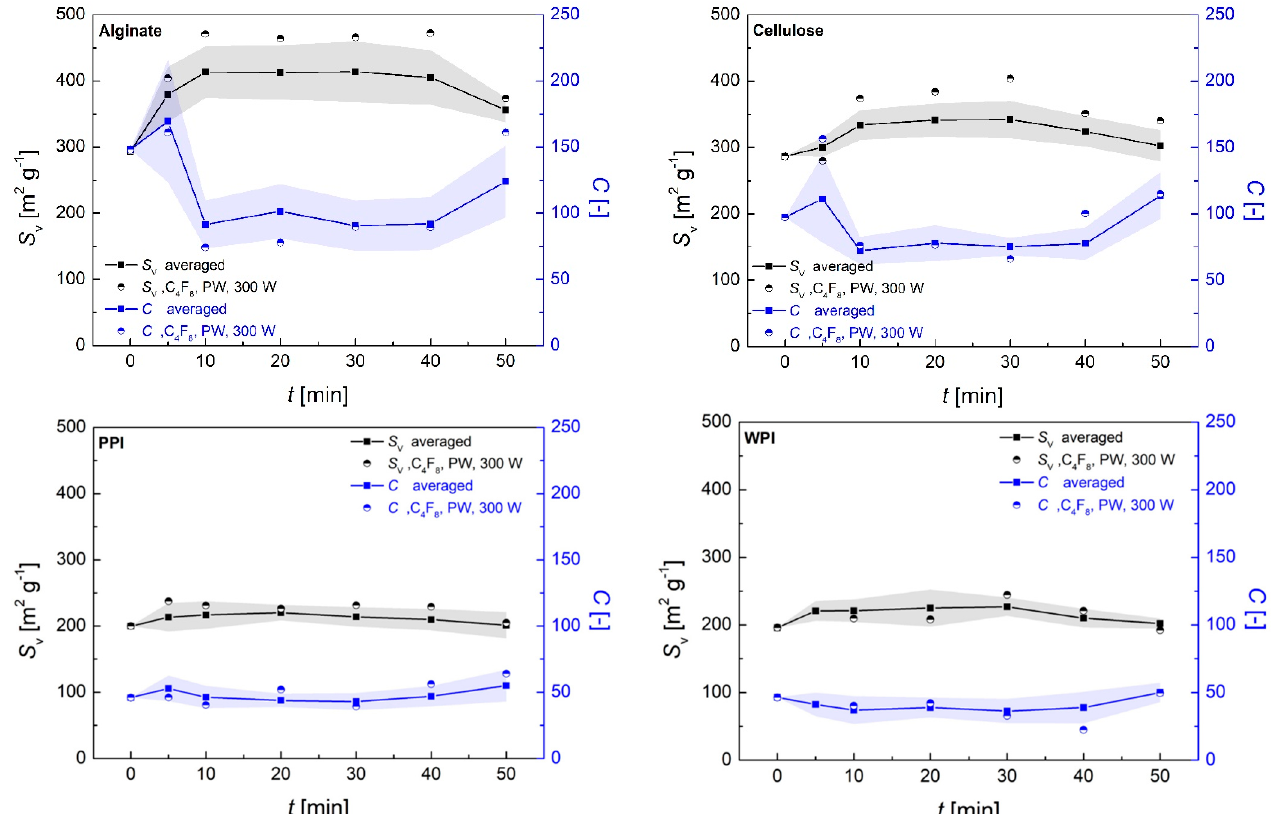
Figure 5. Changes of specific surface area and C-constant depending on process time and process conditions. Circles represent the values obtained with C 4 F 8 monomer in PW mode with p input = 90 W. Squares represent the averaged values from all coating materials and process conditions, excluding PFAC-8 coating in CW mode with p input = 300 W. Error areas represent the standard deviation from averaged values; solid lines are drawn to guide the eyes.